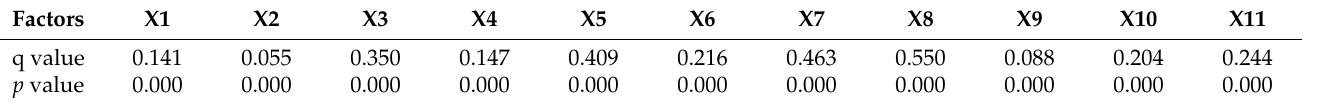
Table 5. q values of factors.